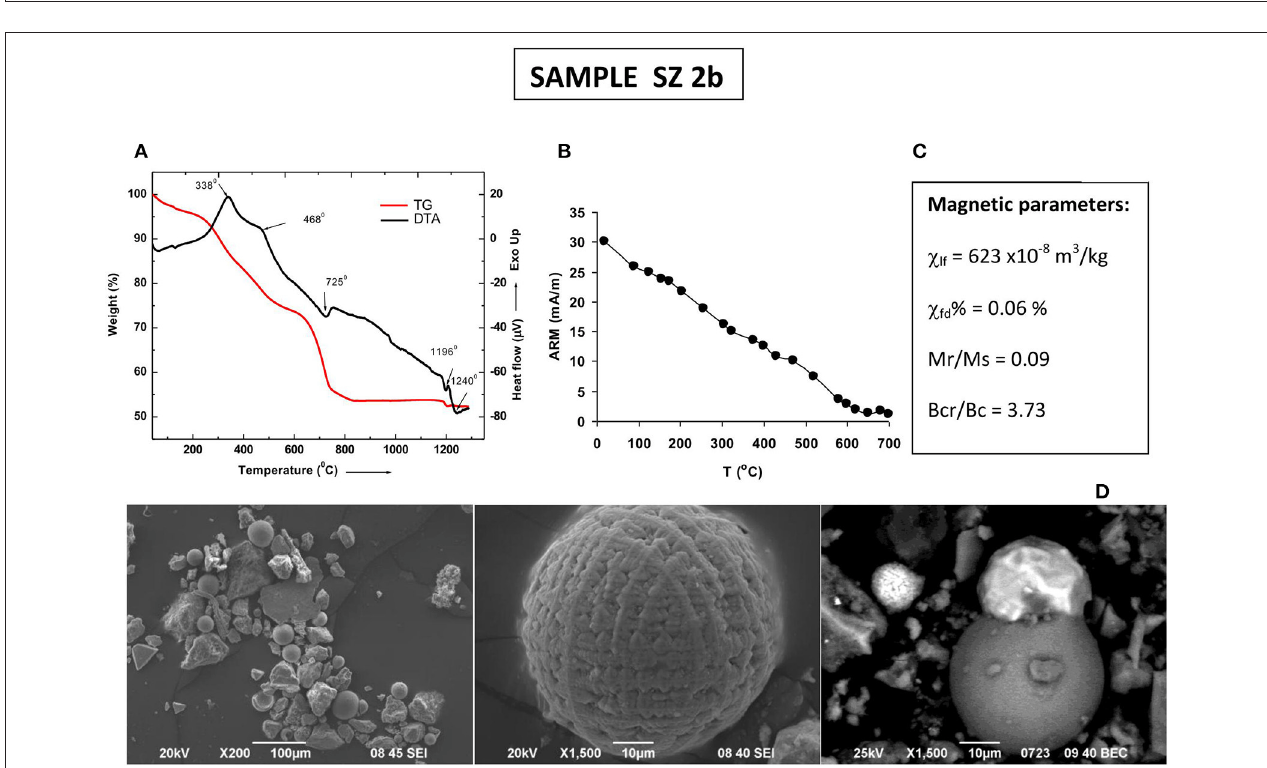
FIGURE 9 | Mineralogical and mineral magnetic characterization of sample SZ 2b. (A) thermogravimetry and differential thermal analysis; (B) stepwise thermal demagnetization of Anhysteretic remanence (ARM); (C) magnetic parameters—bulk low-field susceptibility ( χ ), percent frequency dependent magnetic susceptibility χ fd%, hysteresis ratios; (D) SEM microphotographs of anthropogenic Fe-rich spherules observed in the road dust sample.